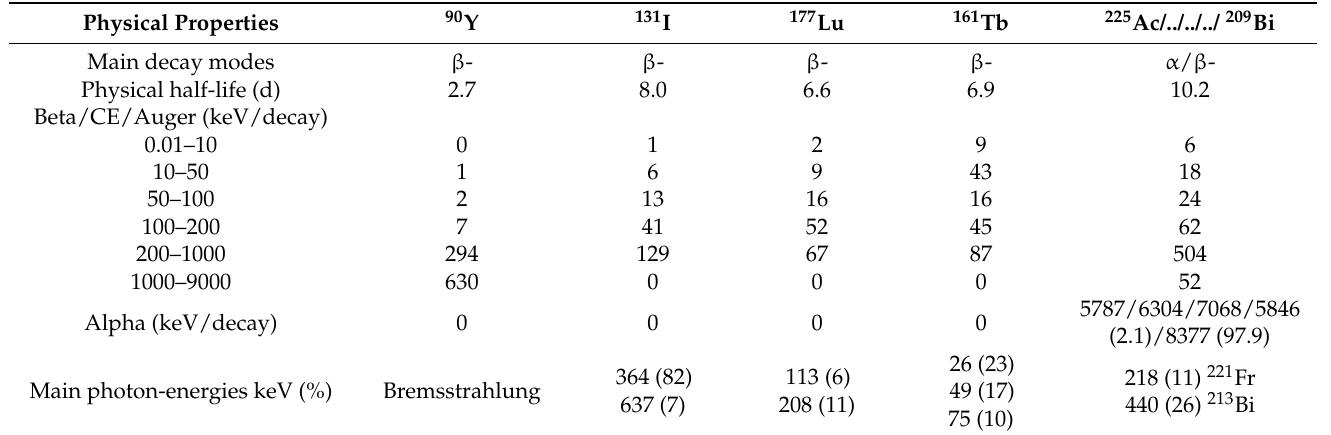
Table 2. Physical properties of the studied radionuclides